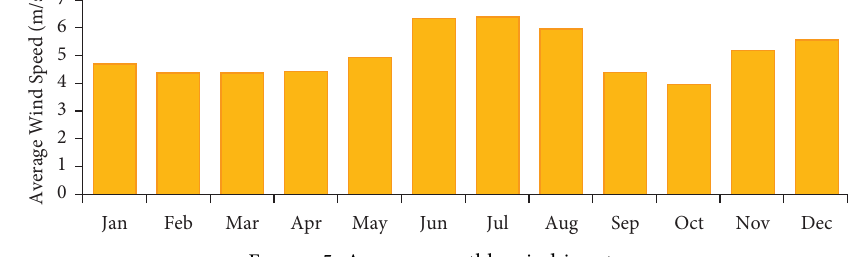
Figure 5: Average monthly wind